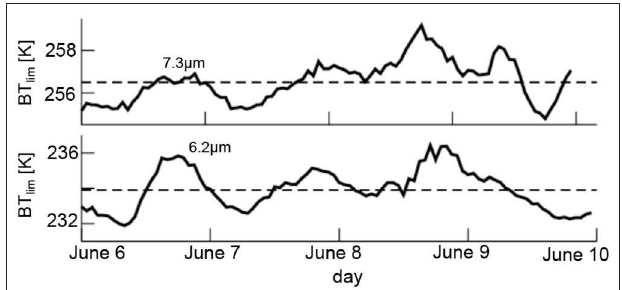
FIGURE 2 | The limit brightness temperature BT lim as a function of time in a short period in summer 2016. BT lim is computed for each ensemble member ( L = 40) every hour and for both water vapor channels. The panels show the ensemble mean BT lim every hour with standard deviation ∼ 1 K (not shown). The dashed horizontal lines denote the temporal average in the given time